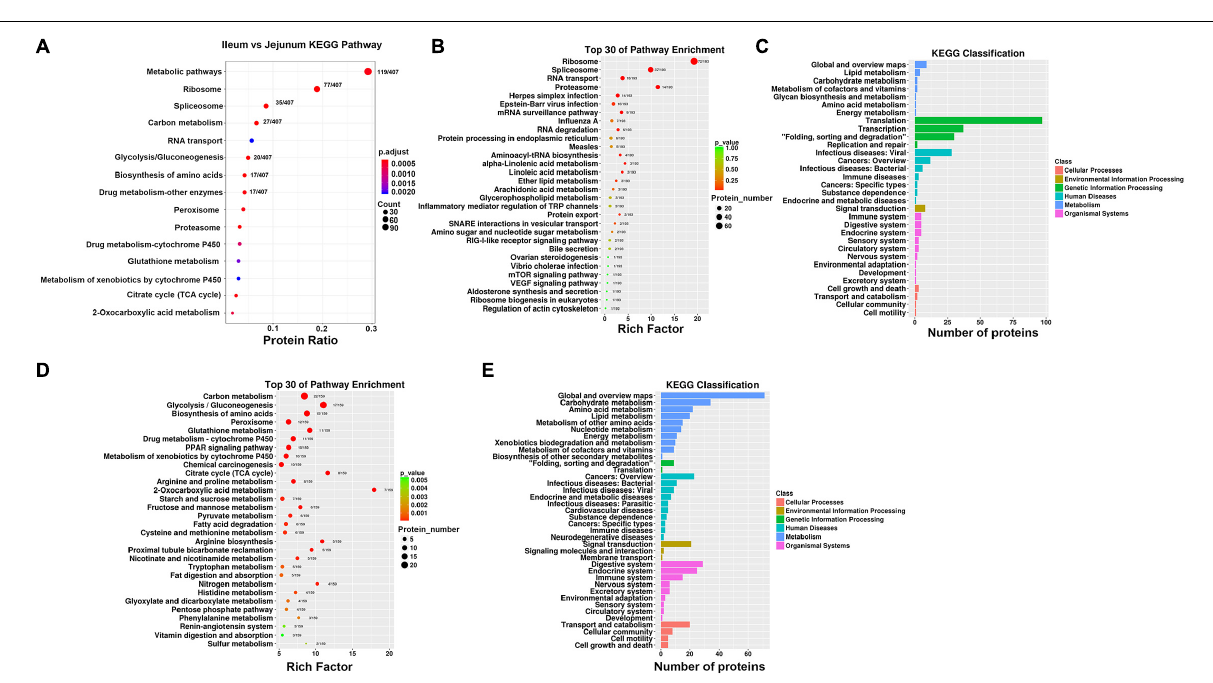
FIGURE 5 | Enrichment analysis of KEGG pathway. (A) KEGG pathway analysis of differentially expressed proteins between ileum and jejunum IEC-Exos. (B) KEGG pathway enrichment analysis of up-regulated protein. (C) KEGG pathway classification of up-regulated protein. (D) KEGG pathway enrichment analysis of down-regulated protein. (E) KEGG pathway classification of down-regulated